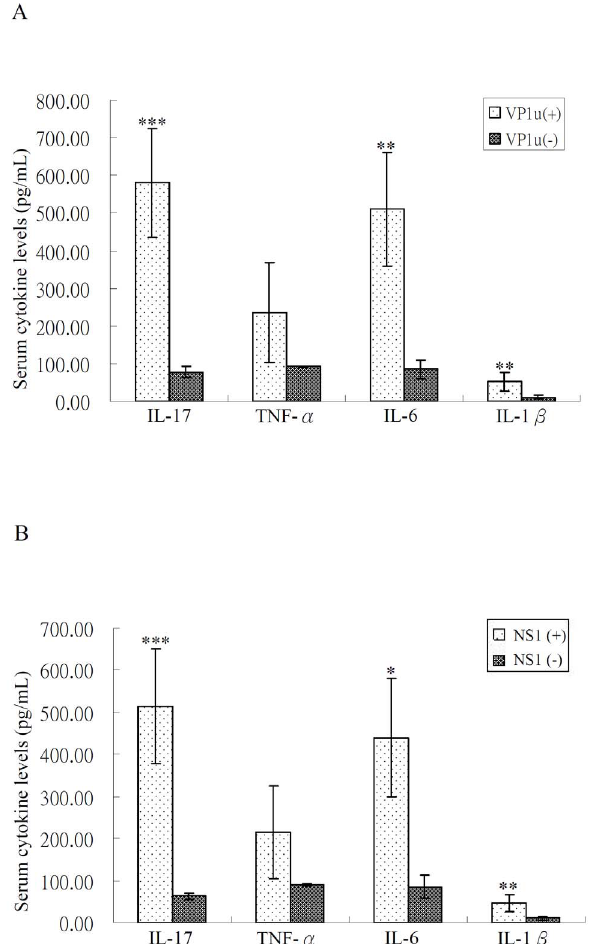
Figure 2. The difference in the levels of IL-17, IL-6, IL-1 b and TNF- a (A) between SLE patients with anti- B19-VP1u IgG [VP1u ( + )] and without anti-B19-VP1u IgG [VP1u ( 2 )], and (B) between SLE patients with anti-B19-NS1 IgG [NS1 ( + )] and without anti-B19-NS1 IgG [NS1( 2 )]. Data are presented as mean ¡ SEM. * p , 0.05, ** p , 0.01, *** p , 0.005, versus SLE patients without anti-B19-VP1u IgG or anti-B19-NS1 IgG.